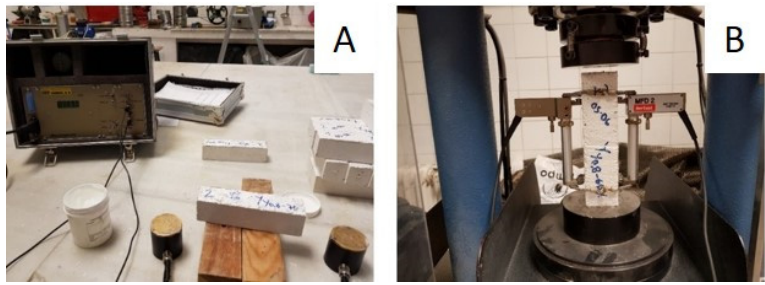
Figure 2. Young’s modulus test: ( A ) Dynamic test; and ( B ) static test.